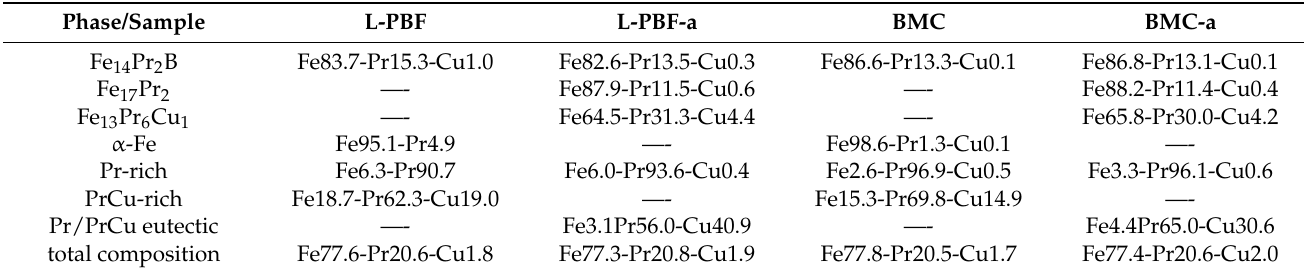
Table 3. Chemical compositions (at%) of occurring phases in additively manufactured ( L-PBF/L-PBF-a ) and book-mold-cast ( BMC/BMC-a ) samples. Phases are deduced from EDX